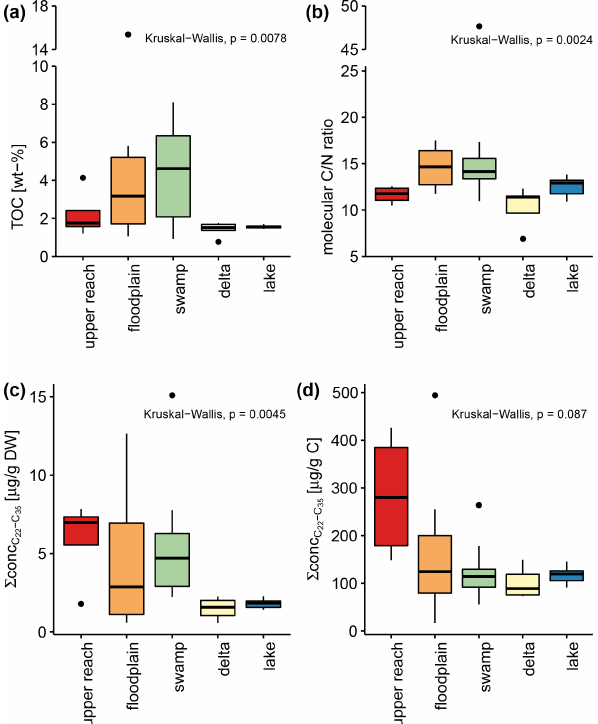
Figure 4. Box-and-whisker plots show total organic carbon con- tent as a percent of dry weight ( a ), carbon-to-nitrogen ratios ( b ), summed concentration of long-chain n -alkanes normalized to dry weight ( c ), and summed concentration of long-chain n -alkanes nor- malized to organic carbon ( d ) of all surface sediments. The colors of each box refer to the assigned sub-environments of the Mkhuze Wetland System. Note that the y axis of (a) and (b) is